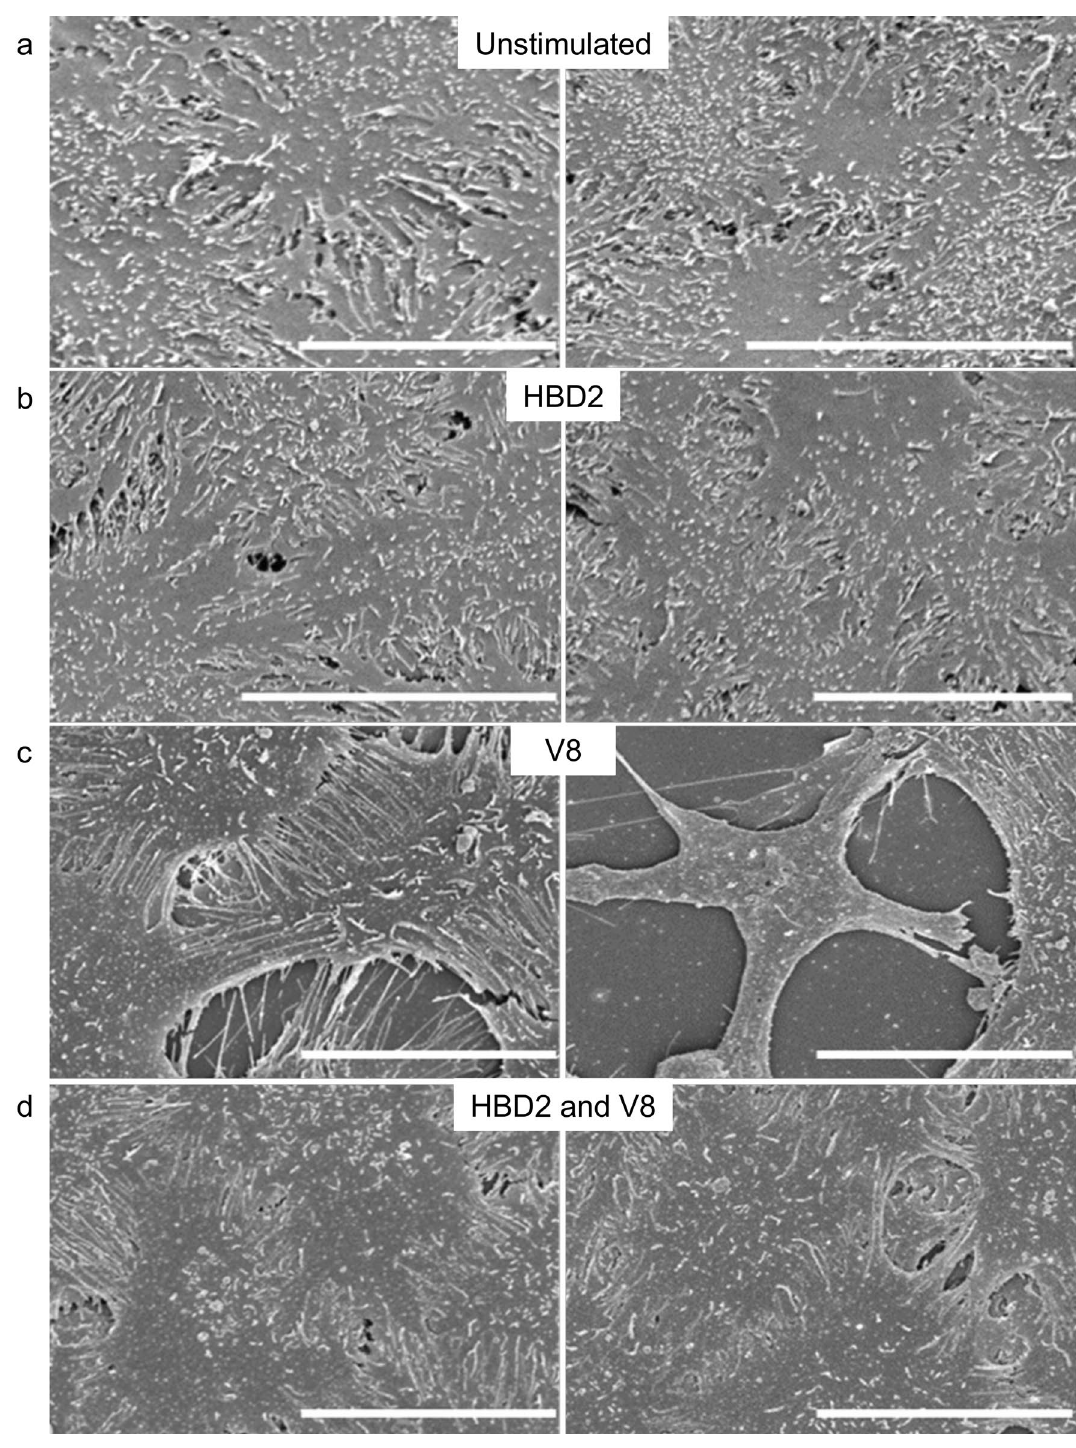
Figure 4. Scanning electron microscopic imaging of HaCaT cells exposed to HBD2 and/or V8. HaCaT cells were seeded into 35 mm corning coated TC dishes. Once confluency was reached, cells were treated with vehicle control ( a , c ) or 0.5 μg/ml synthetic HBD2 ( b , d ). After 24 h, cells were washed and then exposed to vehicle control ( a , b ) or 5 μg/ml recombinant V8 ( c , d ) for an additional 24 h, before cells were fixed with PFA and glutaraldehyde buffer overnight at 4 °C. Cells were then washed; glutaraldehyde buffer was added for a further overnight incubation at 4 °C and prepared for imaging. Samples imaged with the Hitachi S-4700 scanning electron microscope. Scale bars represent 20 μm. Images representative of 5 images taken per